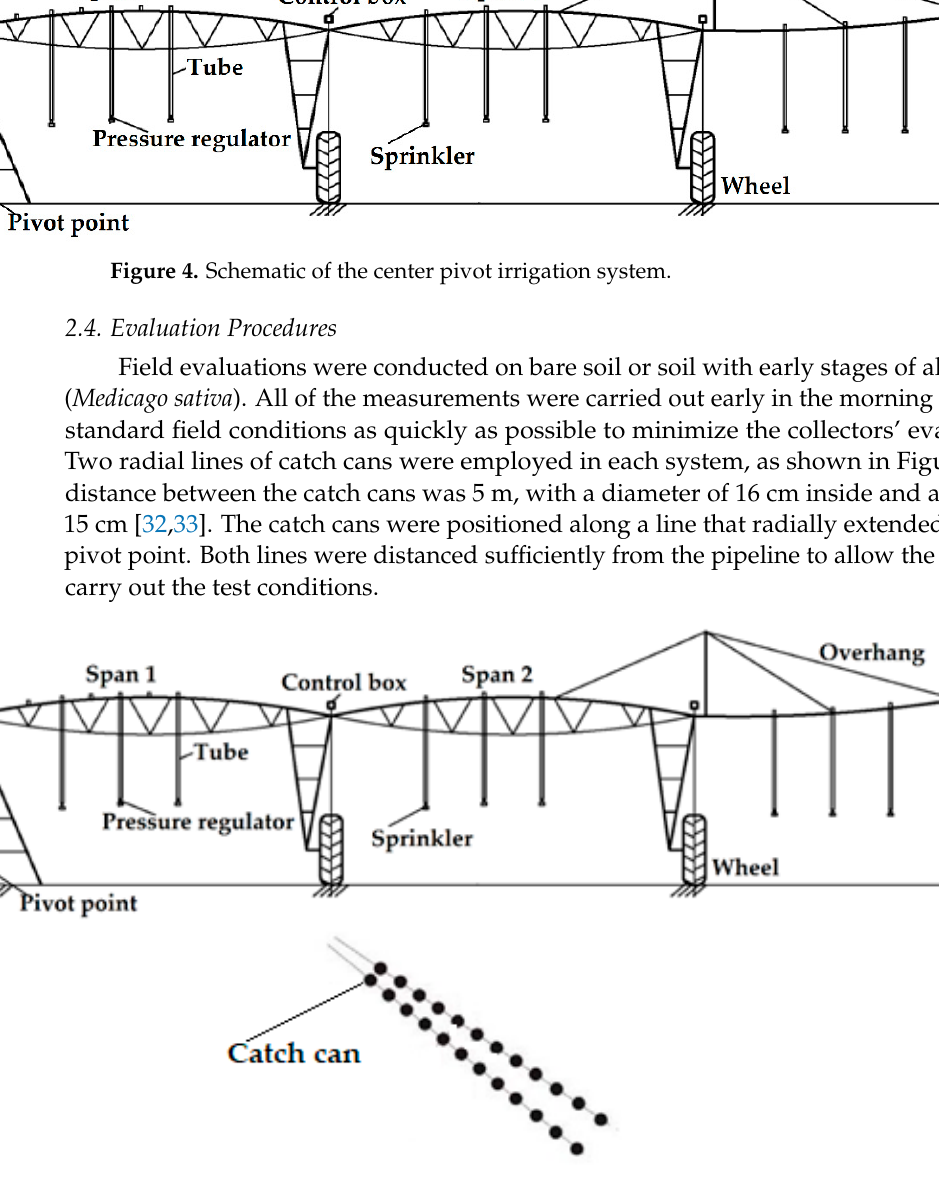
Figure 5. Catch cans arrangement for the performance evaluation of the center pivot irrigation systems.